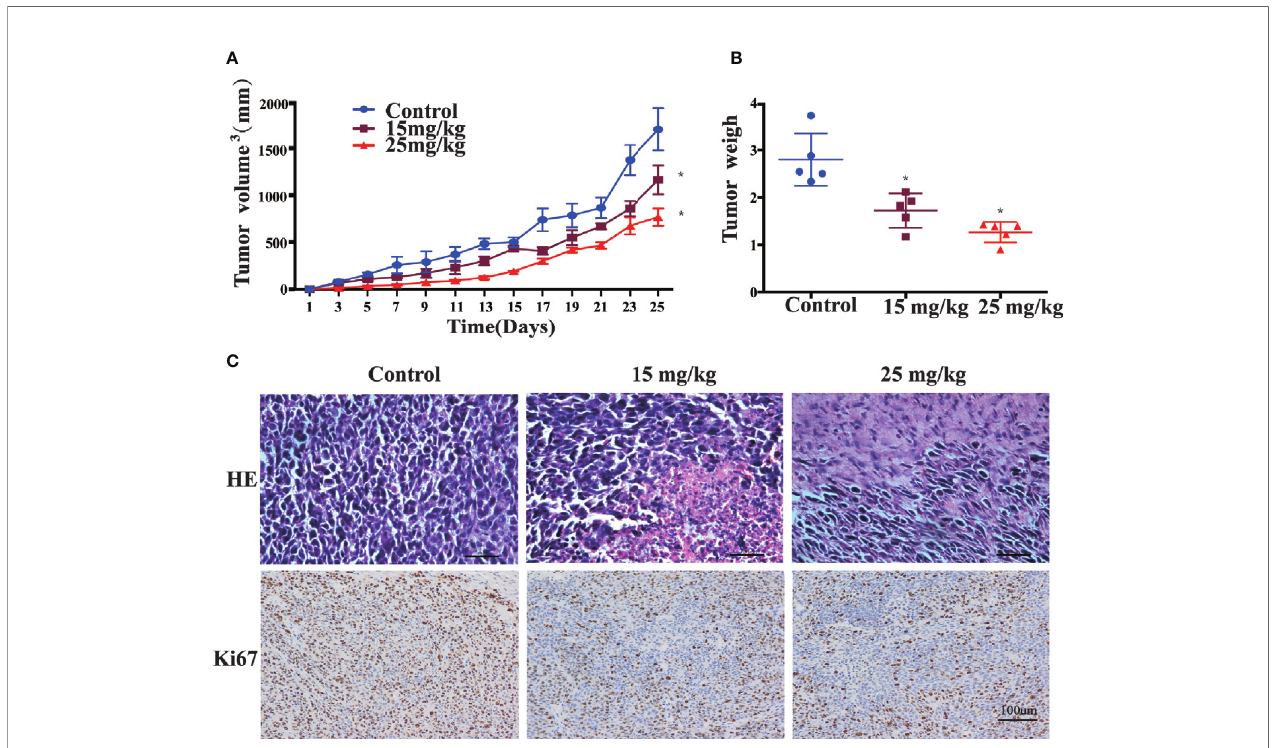
FIGURE 5 | Sophoridine inhibited tumour growth of Lewis-bearing mice and promoted M1 polarisation of macrophages in vivo . (A) Administration of 15 and 25 mg/ kg sophoridine decreased the tumour volume (mm 3 ). (B) Administration of 15 and 25 mg/kg sophoridine decreased the tumour weigh. (C) Administration of 15 and 25 mg/kg sophoridine decreased the in fi ltration of in fl ammatory cells measured by H&E staining, and the expression of Ki67 measured by IHC staining, in tumour tissues from Lewis-bearing mice p < 0.05